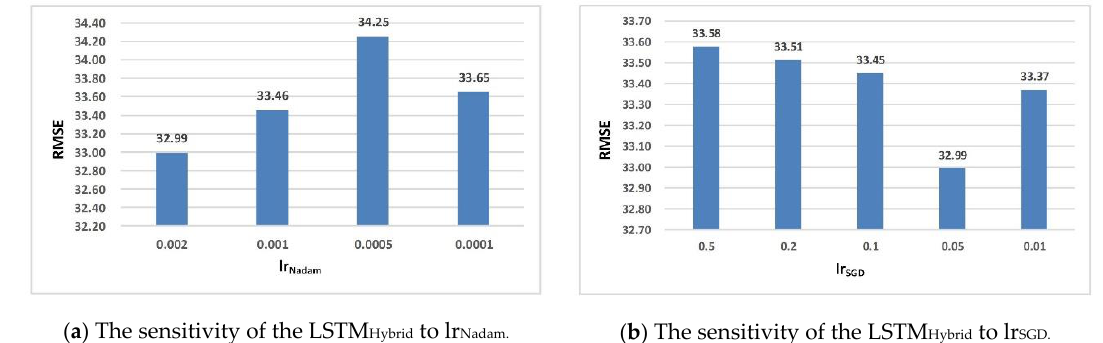
Figure 15. Performances for different learning rates of LSTM Hybrid .